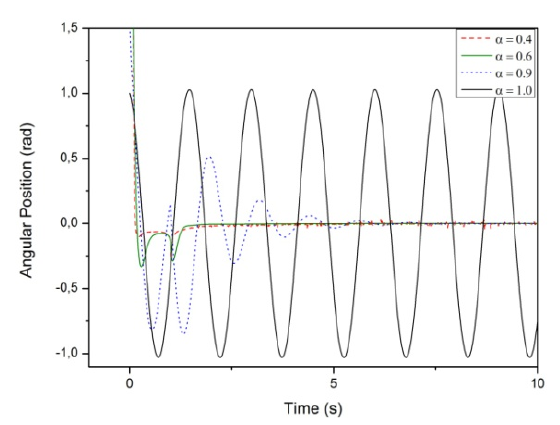
Figure 1. Time history (values of α ≤ 1).